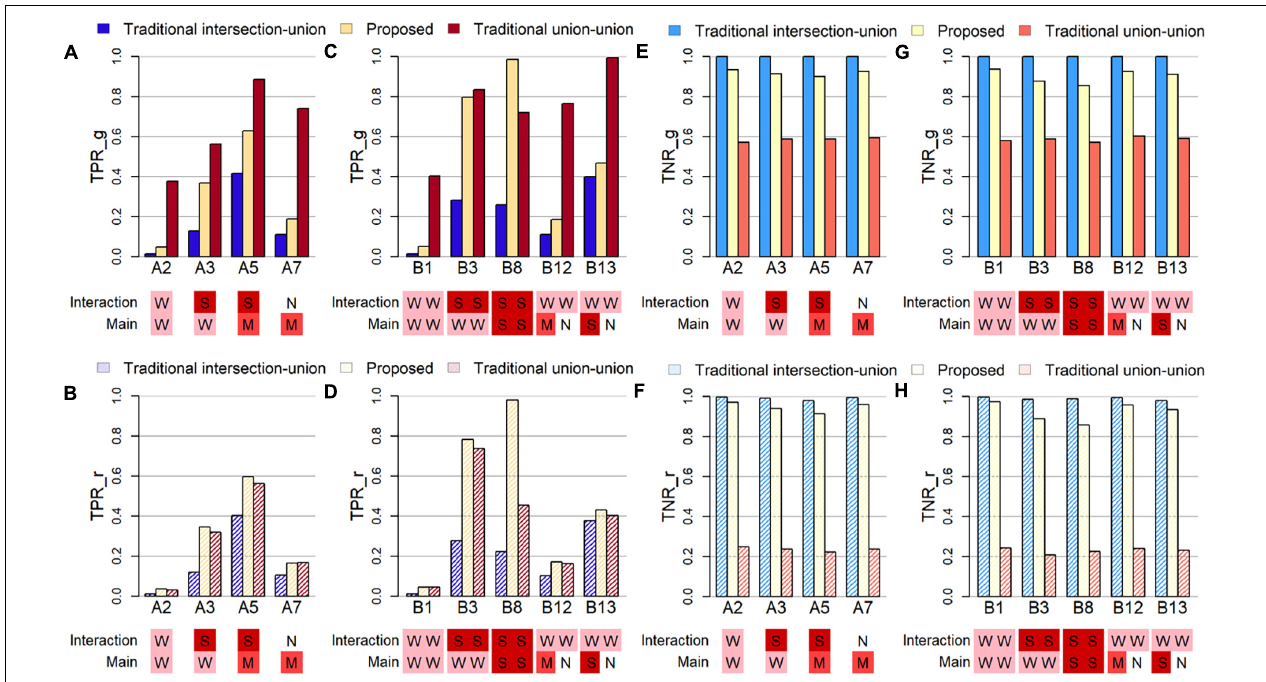
FIGURE 2 | Plots of true positive rates at the gene-level (TPR_g) or region-level (TPR_r) and true negative rates at the gene-level (TNR_g) or region-level (TPR_r) based on selected simulation studies. The letters in colored shades below each figure indicate the degree of effect size of the main and interaction effect in both SNV and CNV. The abbreviations of N, W, M, and S represent Null, Weak, Moderate and Strong, respectively. (A) TPR_g in simulation Part A. (B) TPR_r in simulation Part A. (C) TPR_g in Part B. (D) TPR_r in Part B. (E) TNR_g in Part A. (F) TNR_r in Part A. (G) TNR_g in Part B. (H) THR_r in Part